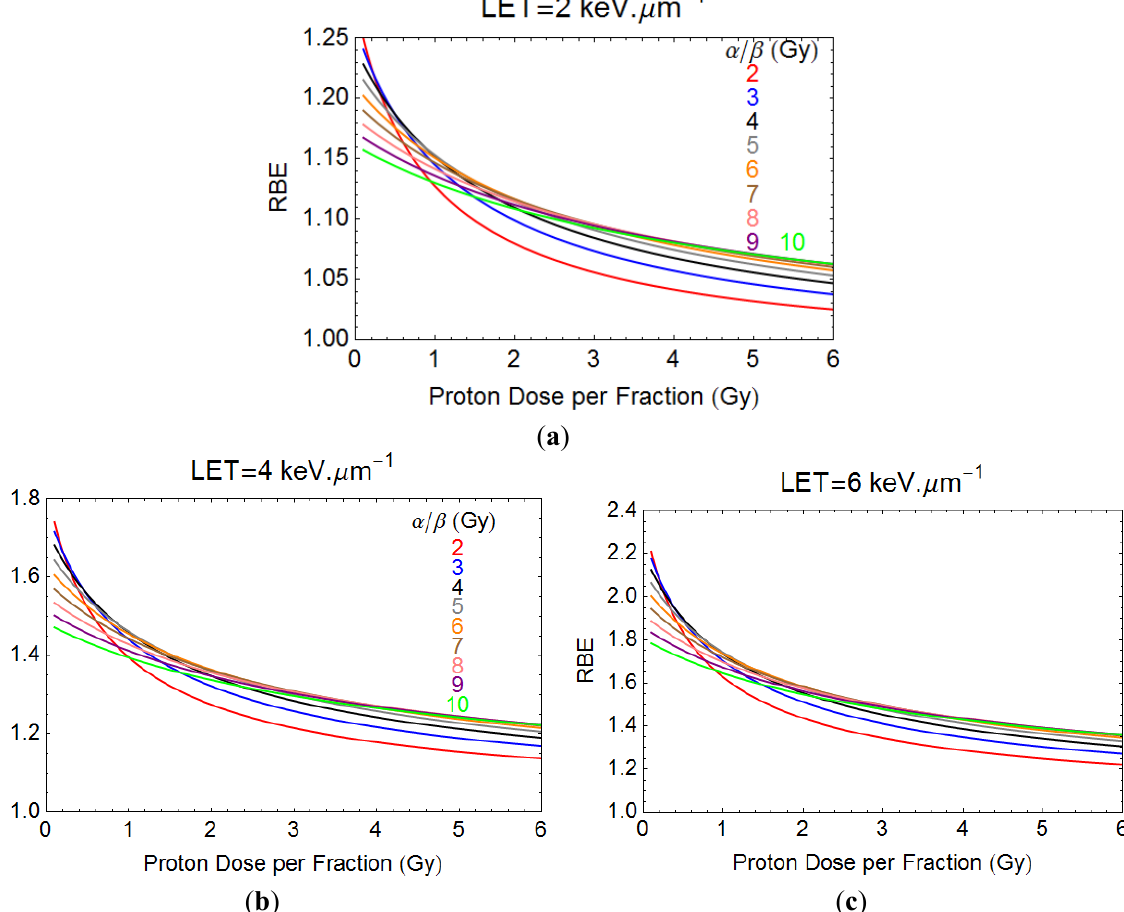
Figure 5. ( a – c ) show plots of RBE with dose per fraction for LET values of 2, 4 and 6 keV·µm −1 .